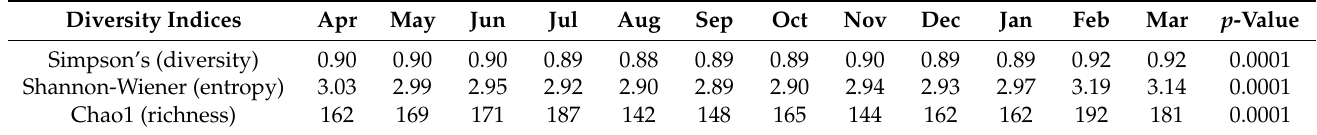
significant differences ( p < 0.005). Table 6. Comparison of the median alpha diversity indices between months. Table 6. Comparison of the median alpha diversity indices between months.